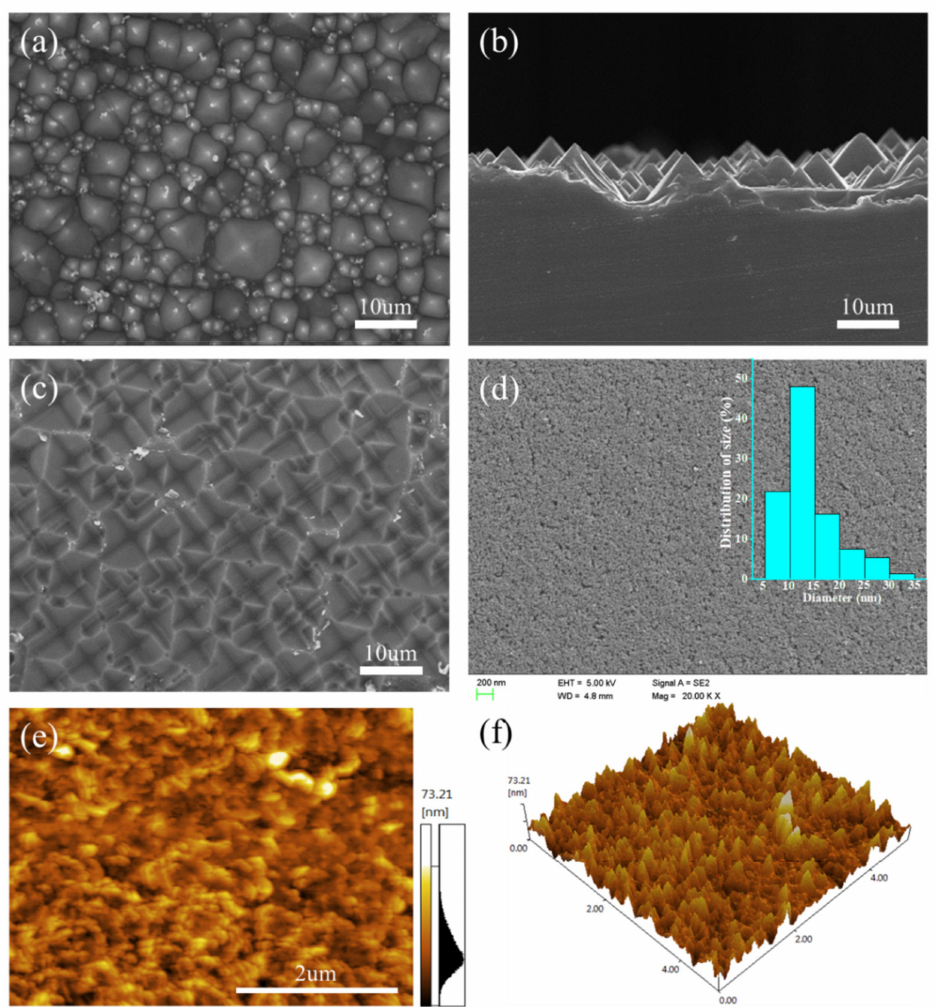
Figure 3. SEM images of the etched silicon wafer: ( a ) top view; ( b ) side view; ( c ) SEM image of the PMMA copy pattern; ( d ) SEM image of the nano-SiO 2 particles of the Si-P surface; ( e , f ) AFM images of the nano-SiO 2 particles of the C-P film